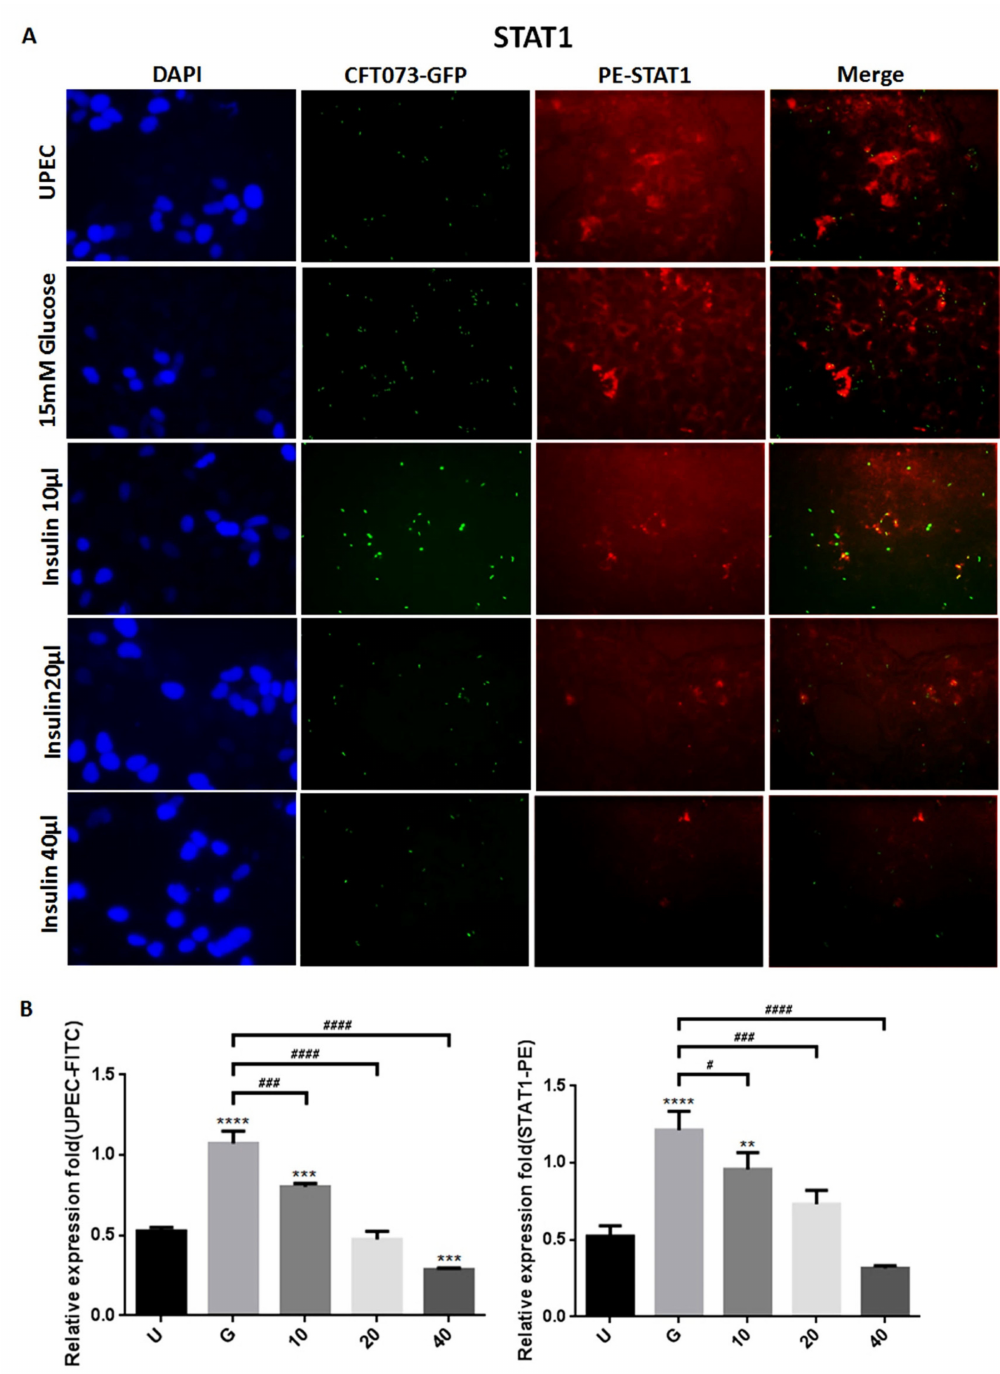
Figure 2. Insulin affected UPEC infection and STAT1 expression in bladder cells. After 24 h of pretreatment with different concentrations of insulin and 15 mM glucose, GFP-UPEC and PE-STAT1 expression in SV-HUC-1 cells post-infection were ( A ) observed by fluorescence microscopy and ( B ) measured using ImageJ software. Cells infected with UPEC alone were used as the positive controls. The data shown are representative of a typical result. DAPI was used to count the number of cells and as a standard for calculating the fluorescence expression ratio of cells. Cell images were captured using a microscope (Leica) at 100 × magnification. Data are expressed as mean ± SD from three separate experiments. The definitions of each letter/number represented by the X axis are: U: UPEC infection alone; G: with 15 mM glucose pretreatment; 10, 20 and 40: pretreated with 10, 20 and 40 µ g/mL insulin, respectively + 15 mM glucose. ** p < 0.01, *** p < 0.001, **** p < 0.0001, compared to positive control groups. # p < 0.05, ### p < 0.001, #### p < 0.0001, compared between the two